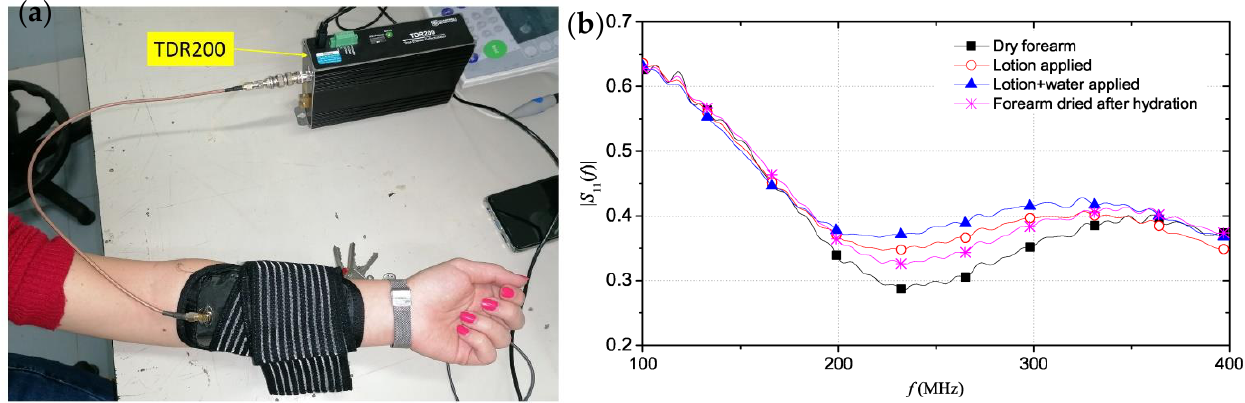
Figure 10. Experimental setup and results of RF reflectometry measurements performed by Schiavoni et al. ( a ) Presents a photograph of the setup with the VNA used to perform the TDR calculations and ( b ) measurement of s-parameters for four cases of forearm hydration. Images reproduced with permission from [90].